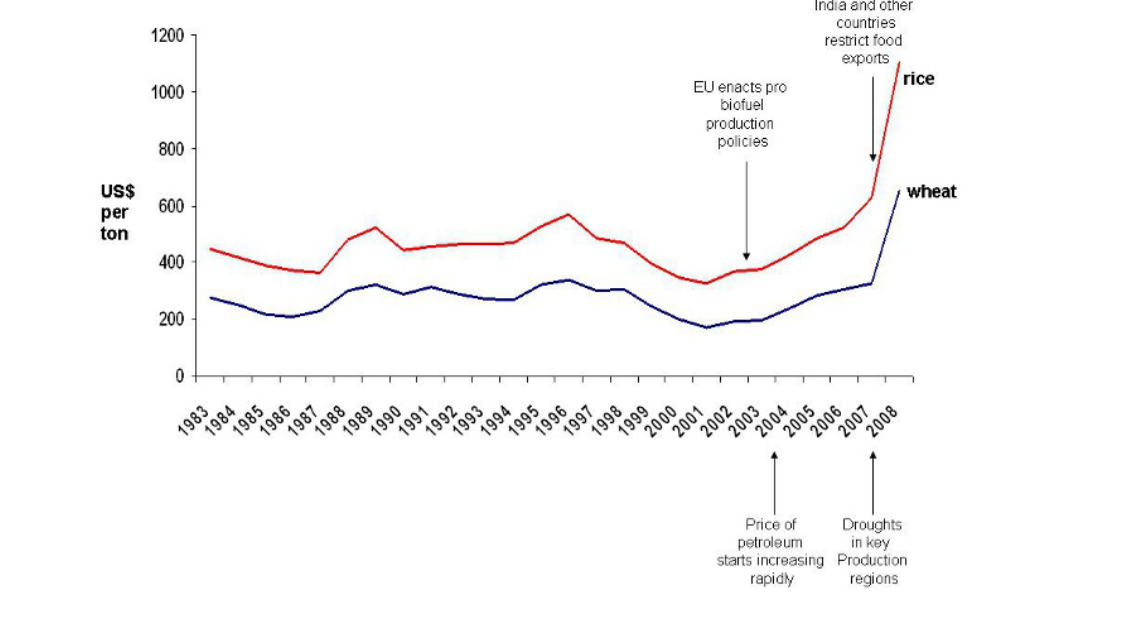
Fig. 1. International prices of rice and wheat from 1983 to 2008 per ton in US$ and timeline of key events in the food price crisis (Headey and Fan 2008, IRRI